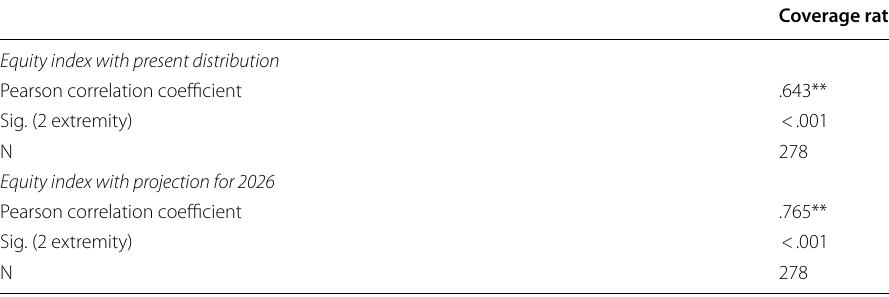
Table 4 Impact of the coverage rate on European funds